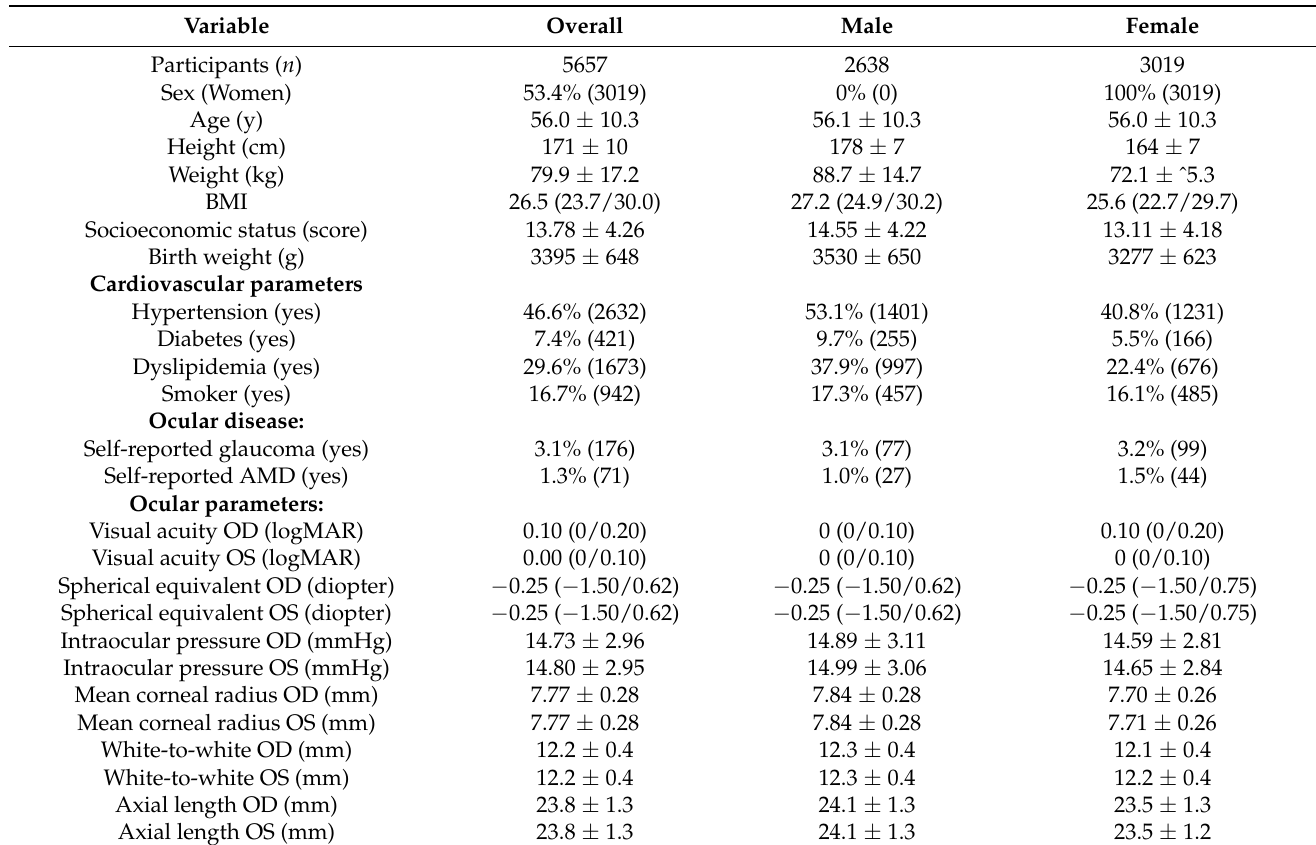
Table 1. Characteristics of the study sample ( n = 5657). Data from the population-based Gutenberg Health Study (2012-17) by sex groups. Mean ± Standard Deviation or Median and 25%/75%